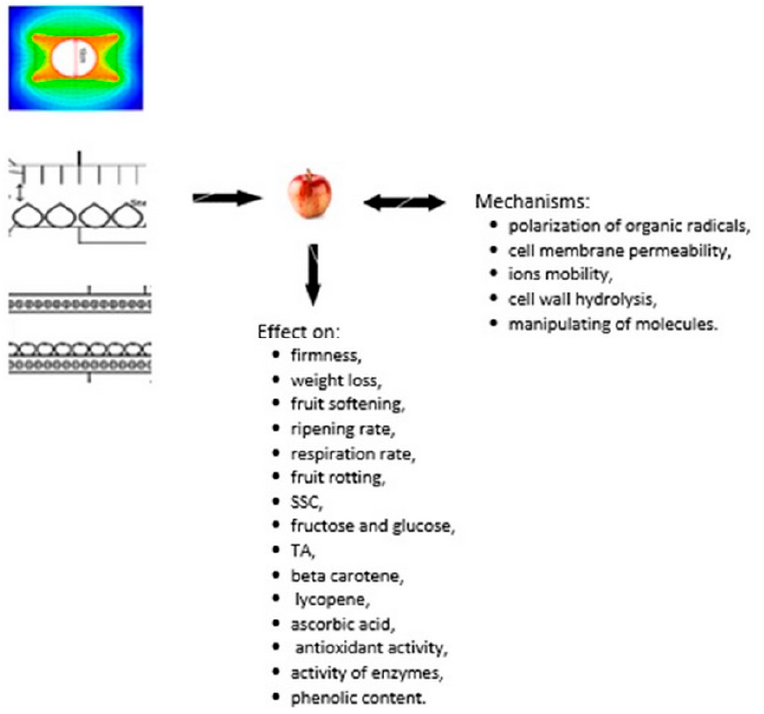
Figure 2. Magnetic and electric field affecting the morphophysiological properties of fruit, with possible mechanisms.